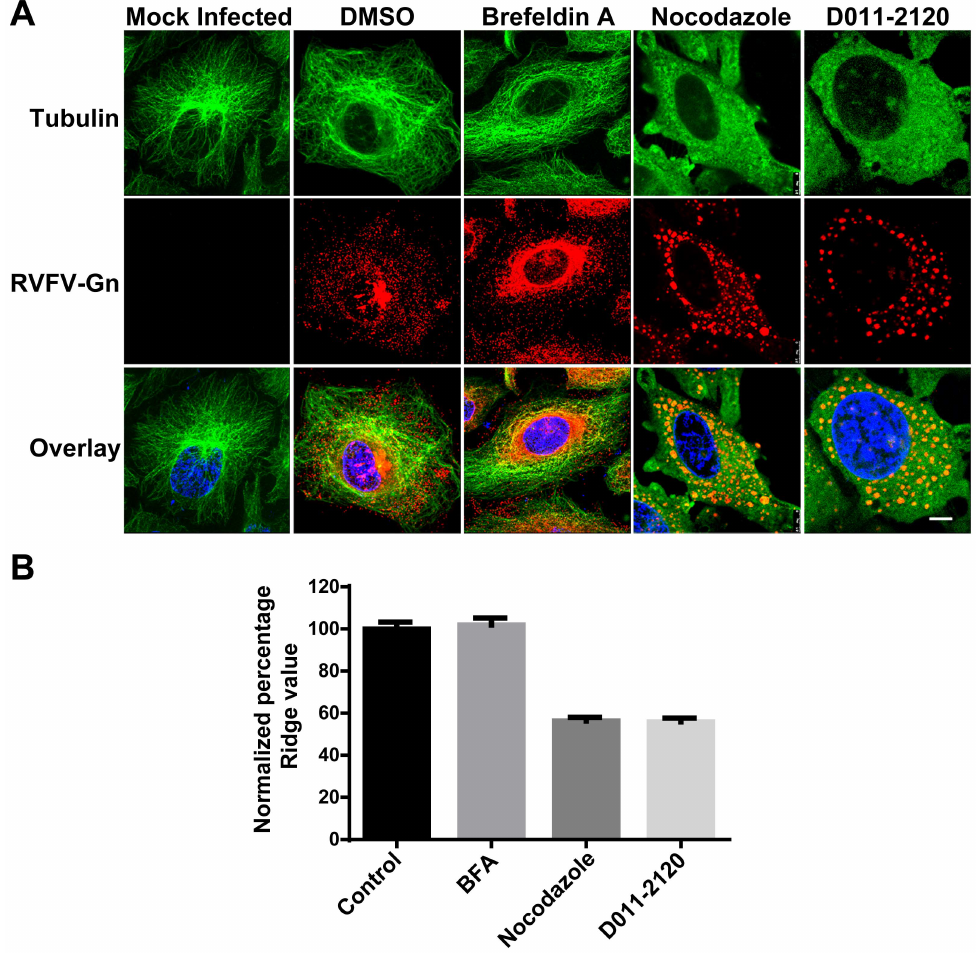
Figure 7. D011-2120 depolymerizes microtubules similar to nocodazole. ( A ) IFA of HeLa cells that were mock infected of infected with MP12 virus for 12 h and either were mock treated or treated with vehicle control (0.5% DMSO), Brefeldin A (100 ng/ml) nocodazole (33 m M), and D011-2120 (50 m M) for 15 min, 4 h or 10 h respectively prior to stopping infection. Cells were immunostained to detect tubulin (green) or RVFV Gn (red). ( B ) HeLa cells in a 96 well plate were treated with D011-2120 or reference compounds for 4 h and immunostained with tubulin antibody. Acquired images were subjected to pattern and ridge analysis (Columbus software) to evaluate differences in microtubulin organization within the cells. Each data point is derived from eight replicates. Percent ridge values were obtained by normalizing each data point with 0.5% DMSO treated cells, which was considered 100%.